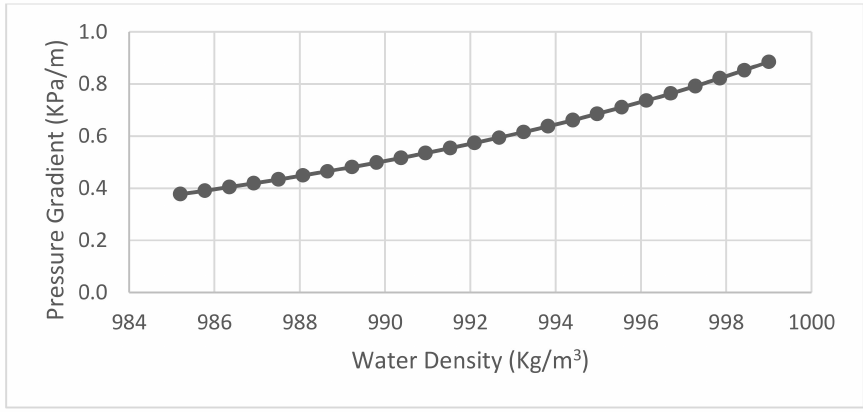
Figure 10. Effect of water density.